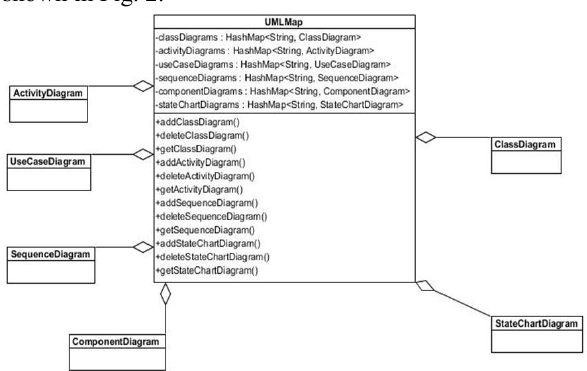
Fig. 2. Reduced class diagram of the UML Map abstract data structure